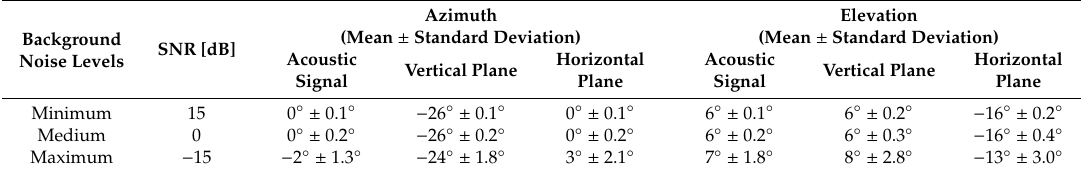
Table 3. Accuracy data obtained for setup 3 tests, using a pulsed acoustic signal.